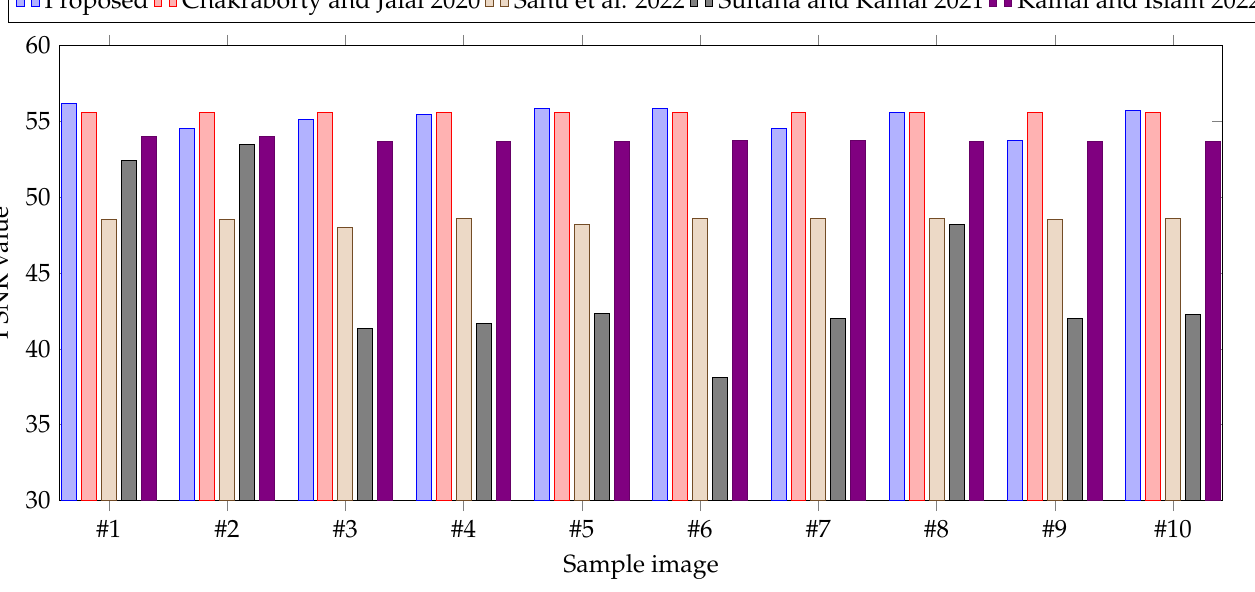
Figure 7. PSNR of different images in different schemes. The figure states that the proposed scheme has the highest PSNR of maximum images [24,25,27,44].